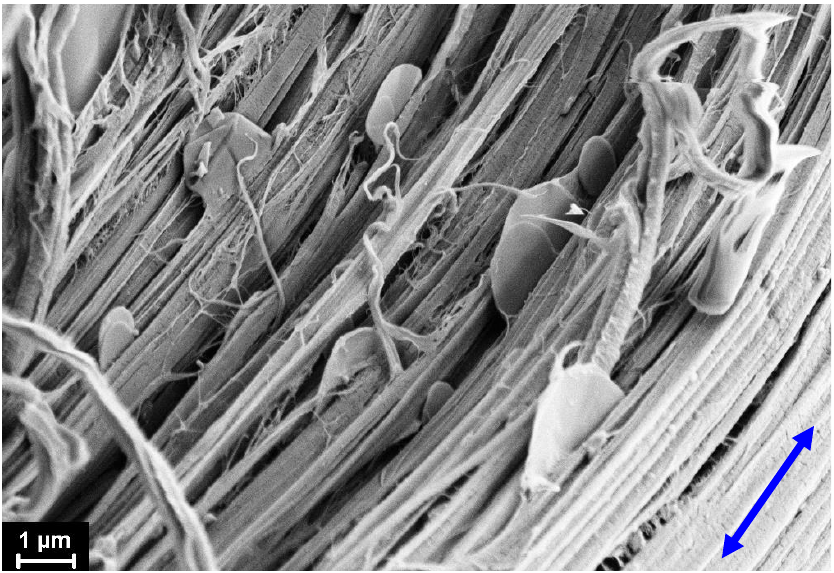
Figure 6. Scanning electron micrograph of the composite fiber drawn up to DR = 8. An arrow indicates the fiber drawing direction.